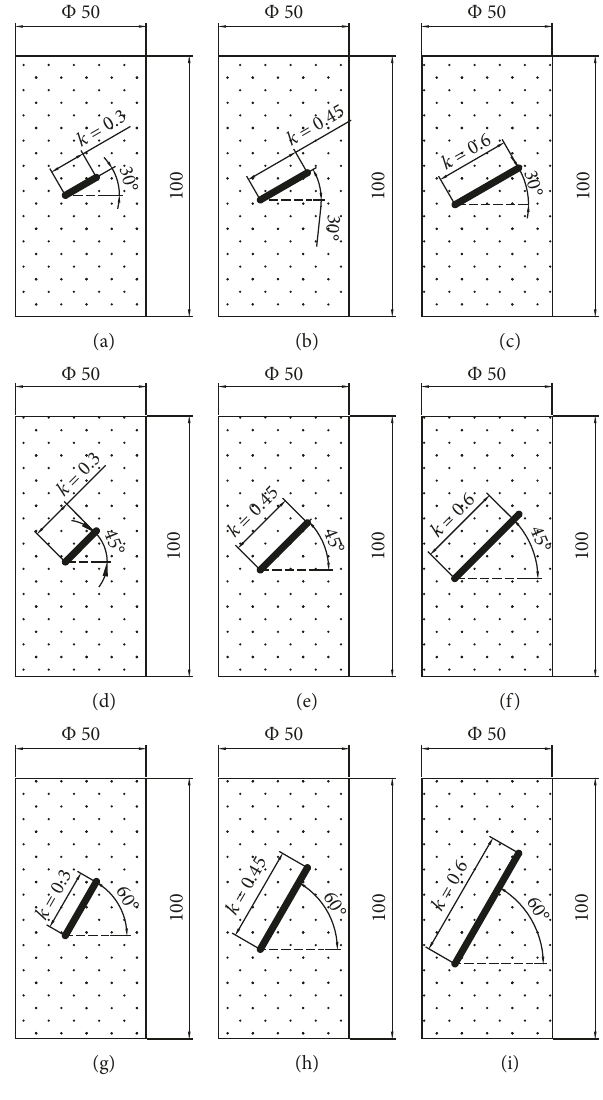
Figure 3: Geometrical